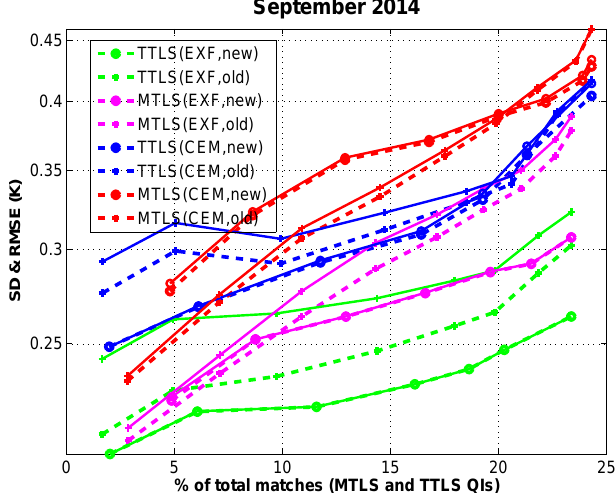
Figure 6. Comparative retrieval results for TTLS and MTLS under two different cloud detection schemes (EXF and CEM) using two different subsets of channels: New (1 3 4 6 11 13) and old (1 4 9 12 13